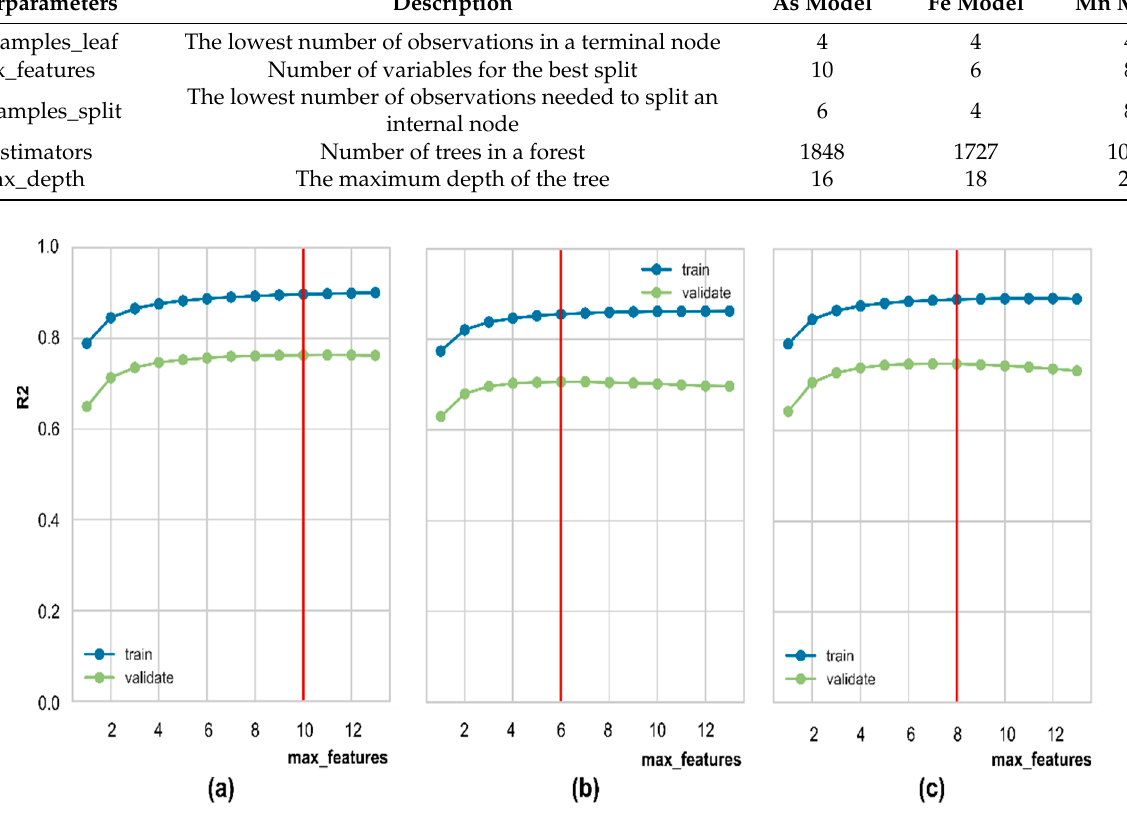
Figure 7. Validation curve of R 2 score versus max_features: ( a ) As model; ( b ) Fe model; ( c ) Mn model. Vertical red lines indicate optimal max_features. Table 3. Random Forest Regressor hyperparameter optimization.